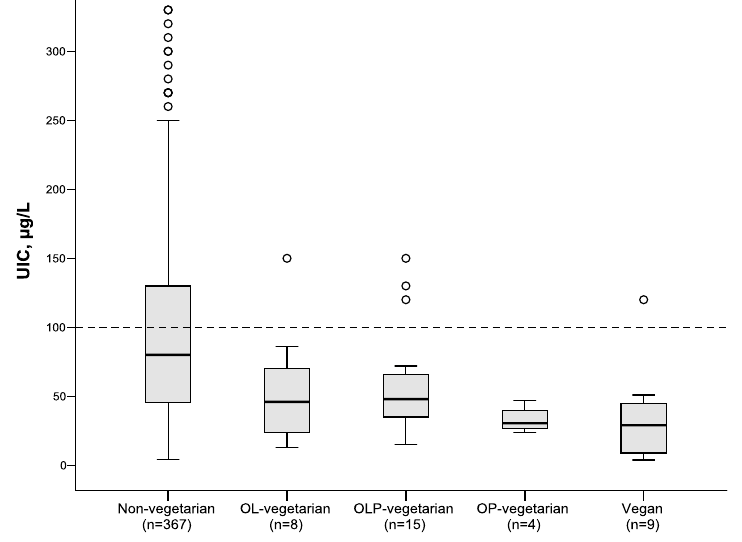
Figure 1. Urinary iodine concentration (UIC) among non-vegetarian women and among women with different vegetarian practices (ovo-lacto (OL), ovo-lacto-pesco (OLP), ovo-pesco (OP). Five observations with UIC > 350 µg/L are not shown in the non-vegetarian group. Box plot details: the horizontal lines indicate the median; the box indicates the interquartile range (IQR) (25th percentile to 75th percentile); the whiskers represent observations within 1.5 times the IQR and the circles are observations larger than 1.5 times the IQR. The stippled horizontal line marks the epidemiological criteria for assessing adequate iodine intake based on the median UIC by the World Health Organization [1].